Question: Looking at the figure, what chart type is it?
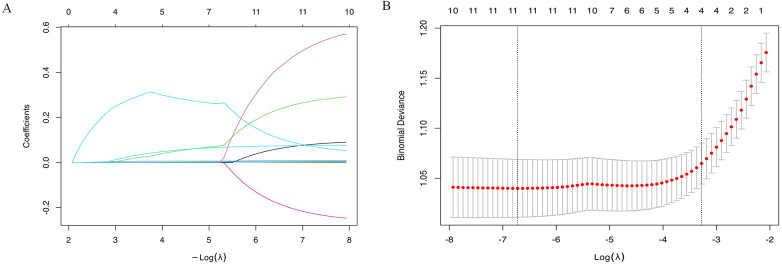
Answer: line